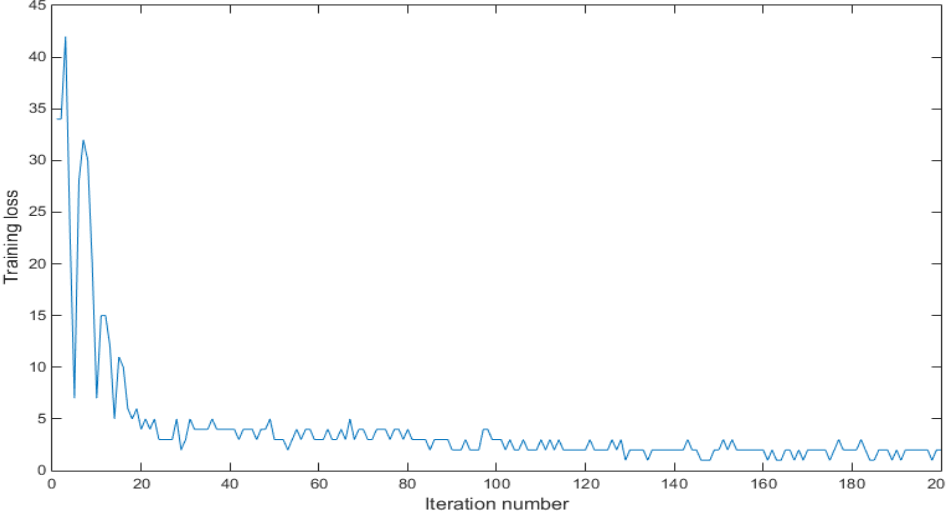
Figure 4. The curve of training process for our method